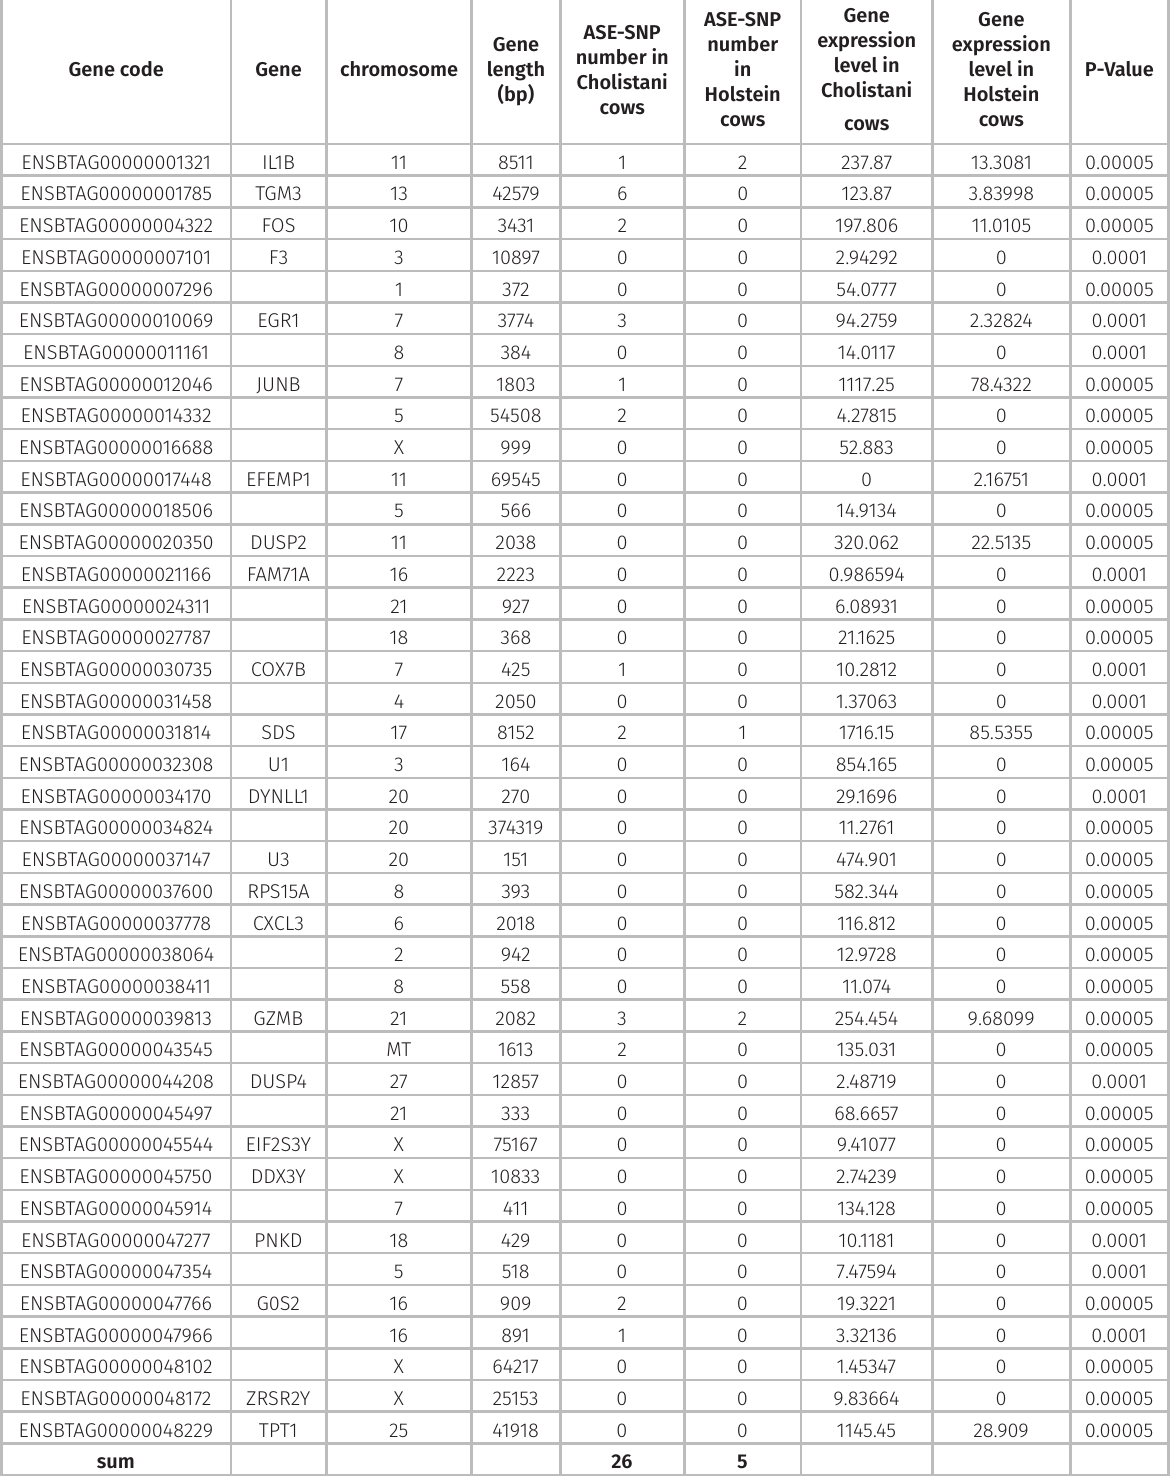
Table III. ASE-SNP number in gene level and gene expression level in two cow’s population. Gene code Gene chromosome